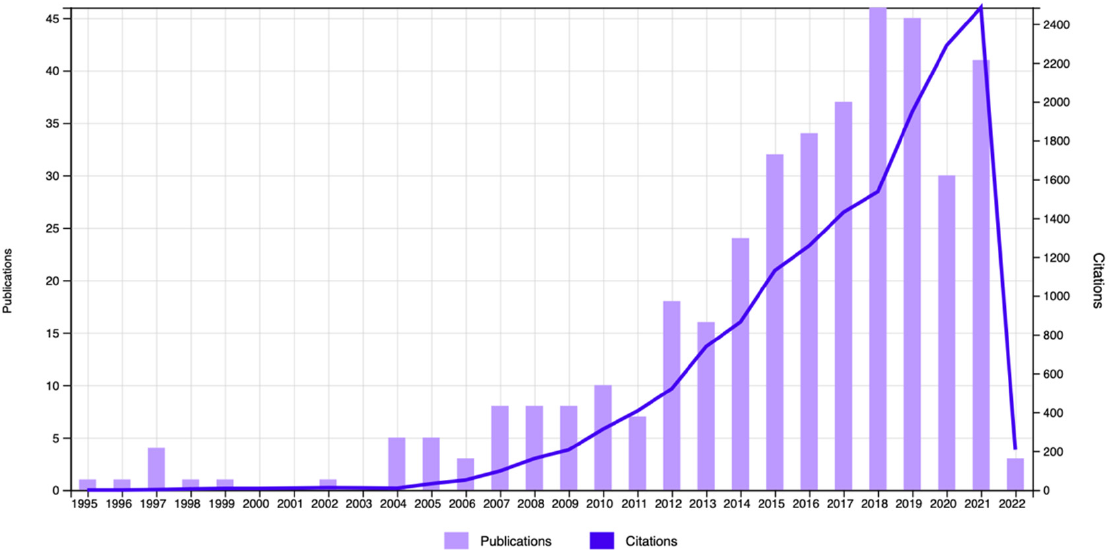
Figure 2. Distribution of articles in the domain of “Environemental Design” and “Autism” for the years 2001–2022.